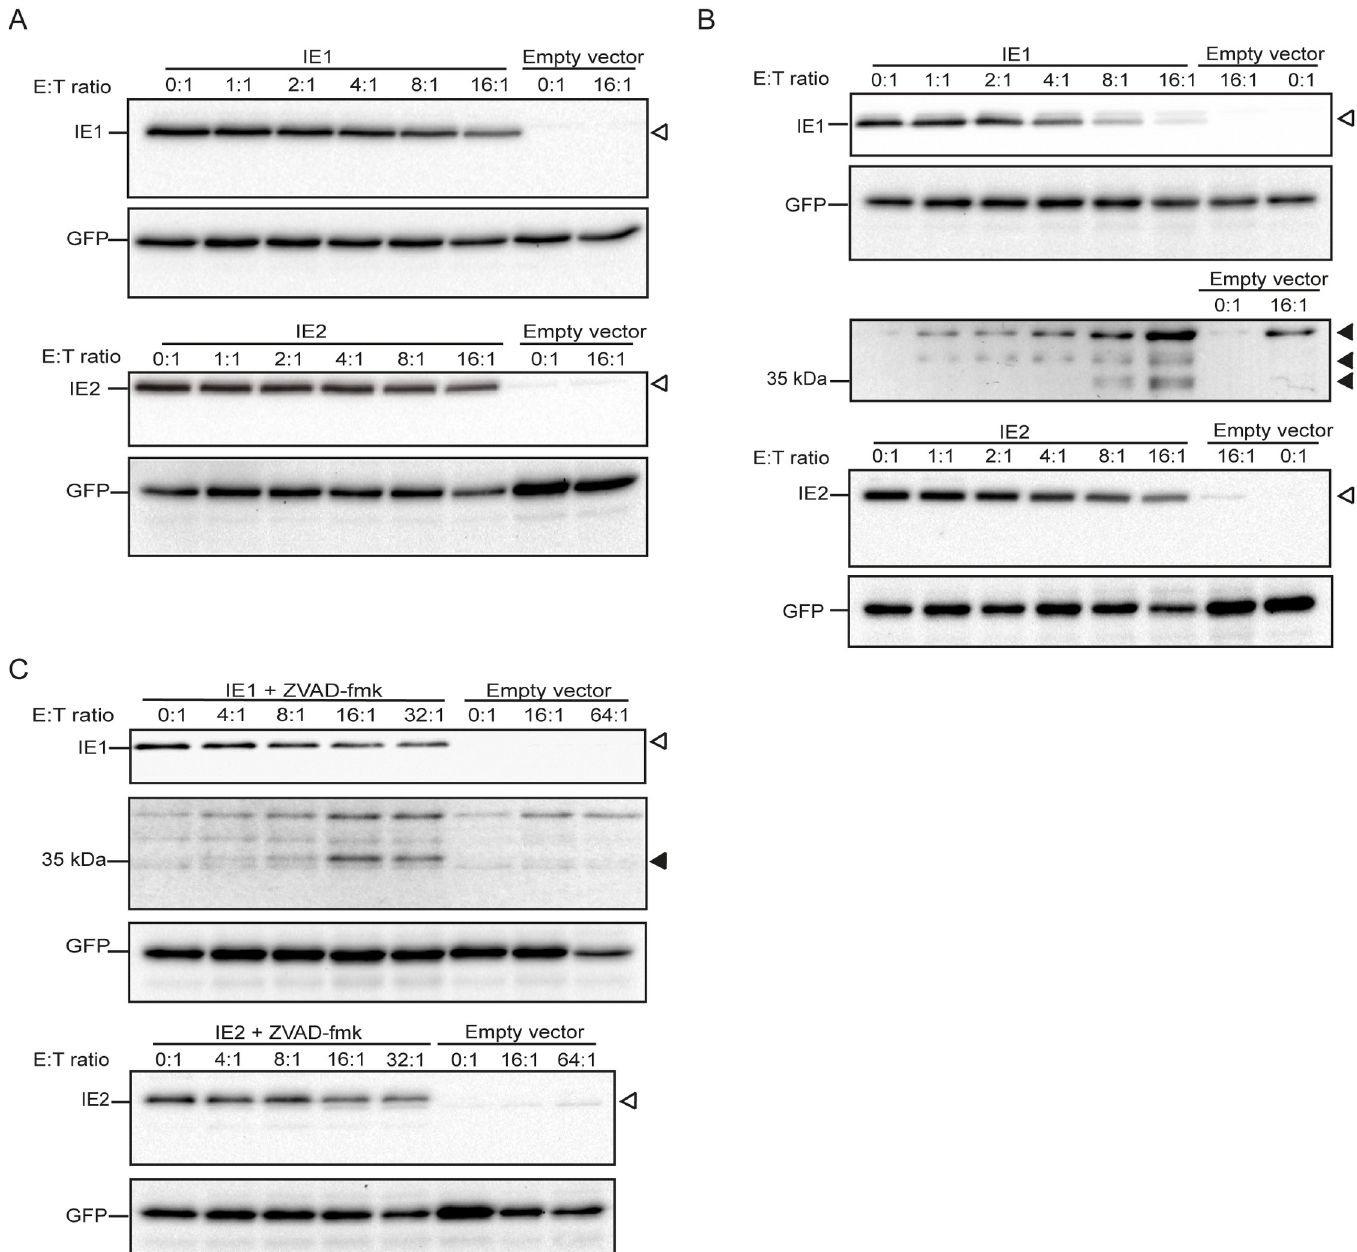
Fig 2. Immune effector cells target IE1 and IE2. HeLa cells were transfected with N-terminal HA-tagged IE1, IE2, or empty vector combined with GFP. 20 h post- transfection, (A) LAK cells or (B) NK cells (YT-Indy) were added with increasing E:T ratios for 6 h. (C) Caspase inhibitor ZVAD-fmk was added (100 μ M) before challenging by NK cells. Lysates were subjected to immunoblotting using either an anti-HA or anti-GFP antibody. White and black triangles indicate full length IE proteins and IE degradation products, respectively.